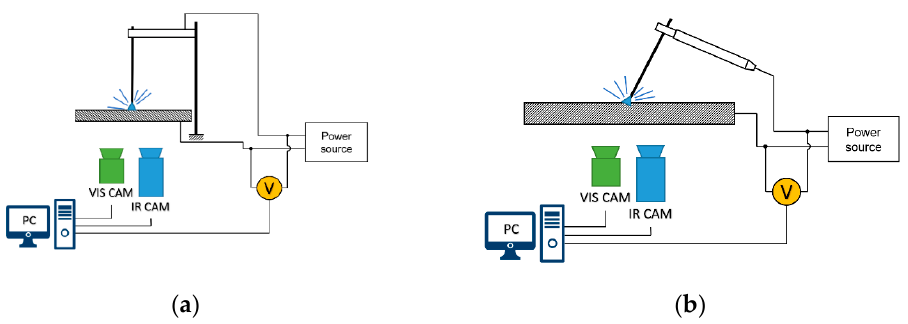
Figure 4. Illustration of test stands used in research: ( a ) stand for welding arc examination; ( b ) manual cladding